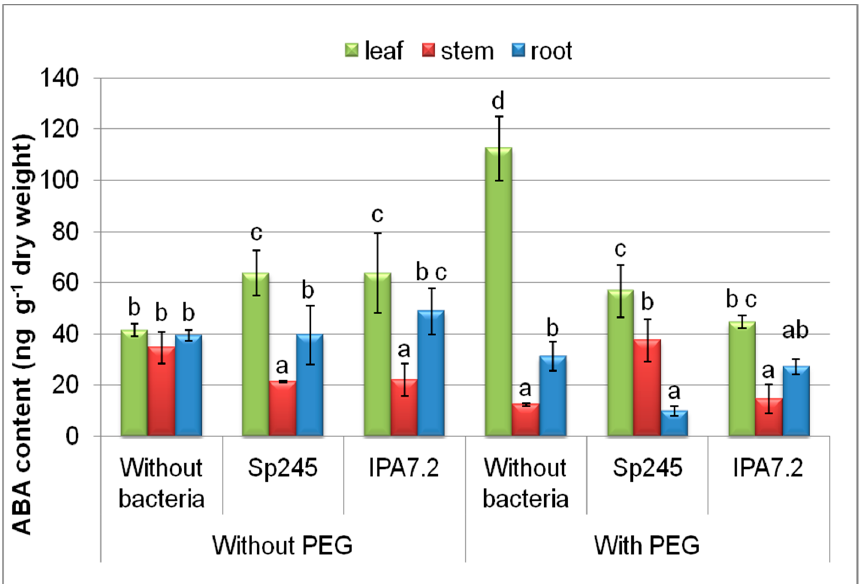
Figure 2. The effect of PEG and microplants’ inoculation with bacterial strains ( A. brasilense Sp245 and O. cytisi IPA7.2) on the content of ABA in organs of potato plants cultivated in vitro. Means±SE ( n = 6) marked with similar Latin letters do not differ significantly according to the LSD-test ( p ≤ 0.05).